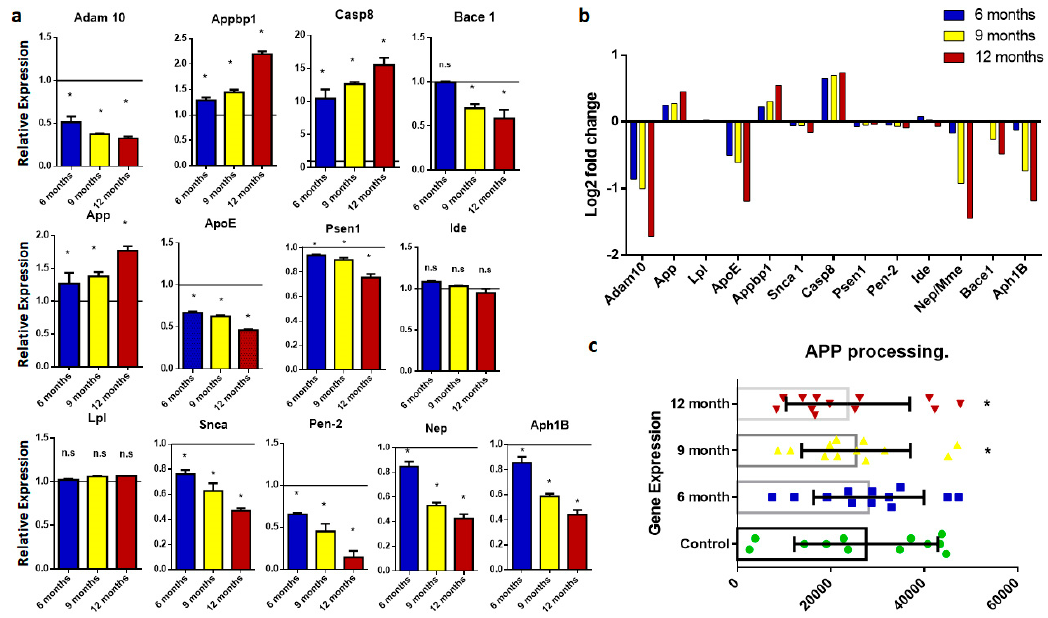
Figure 1. Expression analysis of genes involved in amyloid precursor protein procession. ( a ) Histograms representing relative mRNA expression of Adam10 , App , Lpl , Appb1 , ApoE , Snca , Casp8 , Psen1 , Pen-2 , Bace 1 , Ide , Nep , Ncstn , and Aph1B . Represented values are the mean and SD obtained from three individual experiments performed for each sample. The line on the x-axis at 1.0 shows the gene expression of control samples. ( b ) Bar plots representing fold-change values represented in the log2 scale showing gene expression in the brain of six-, nine-, and 12-month-old samples. Baseline shows expression in control samples. ( c ) Scattered-dot plot shows gene expression involved in amyloid protein processing. * Expression is significantly different to wild type (WT) ( p ≤ 0.05). n.s., Nonsignificant.